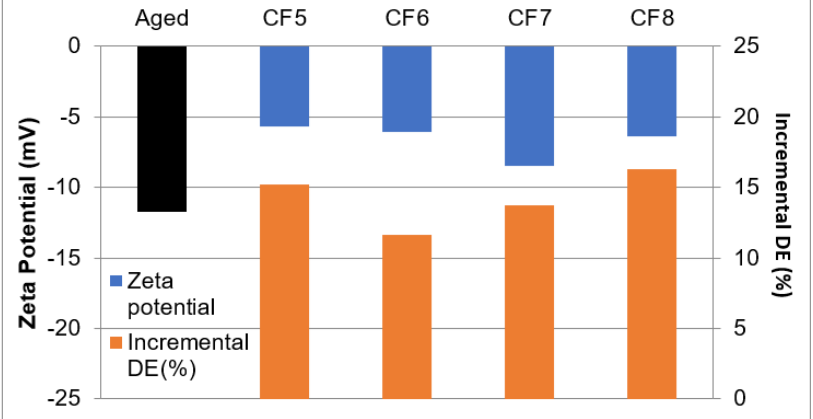
Figure 16. Average zeta potential (pH 3–pH 6) compared to DE (category 2).